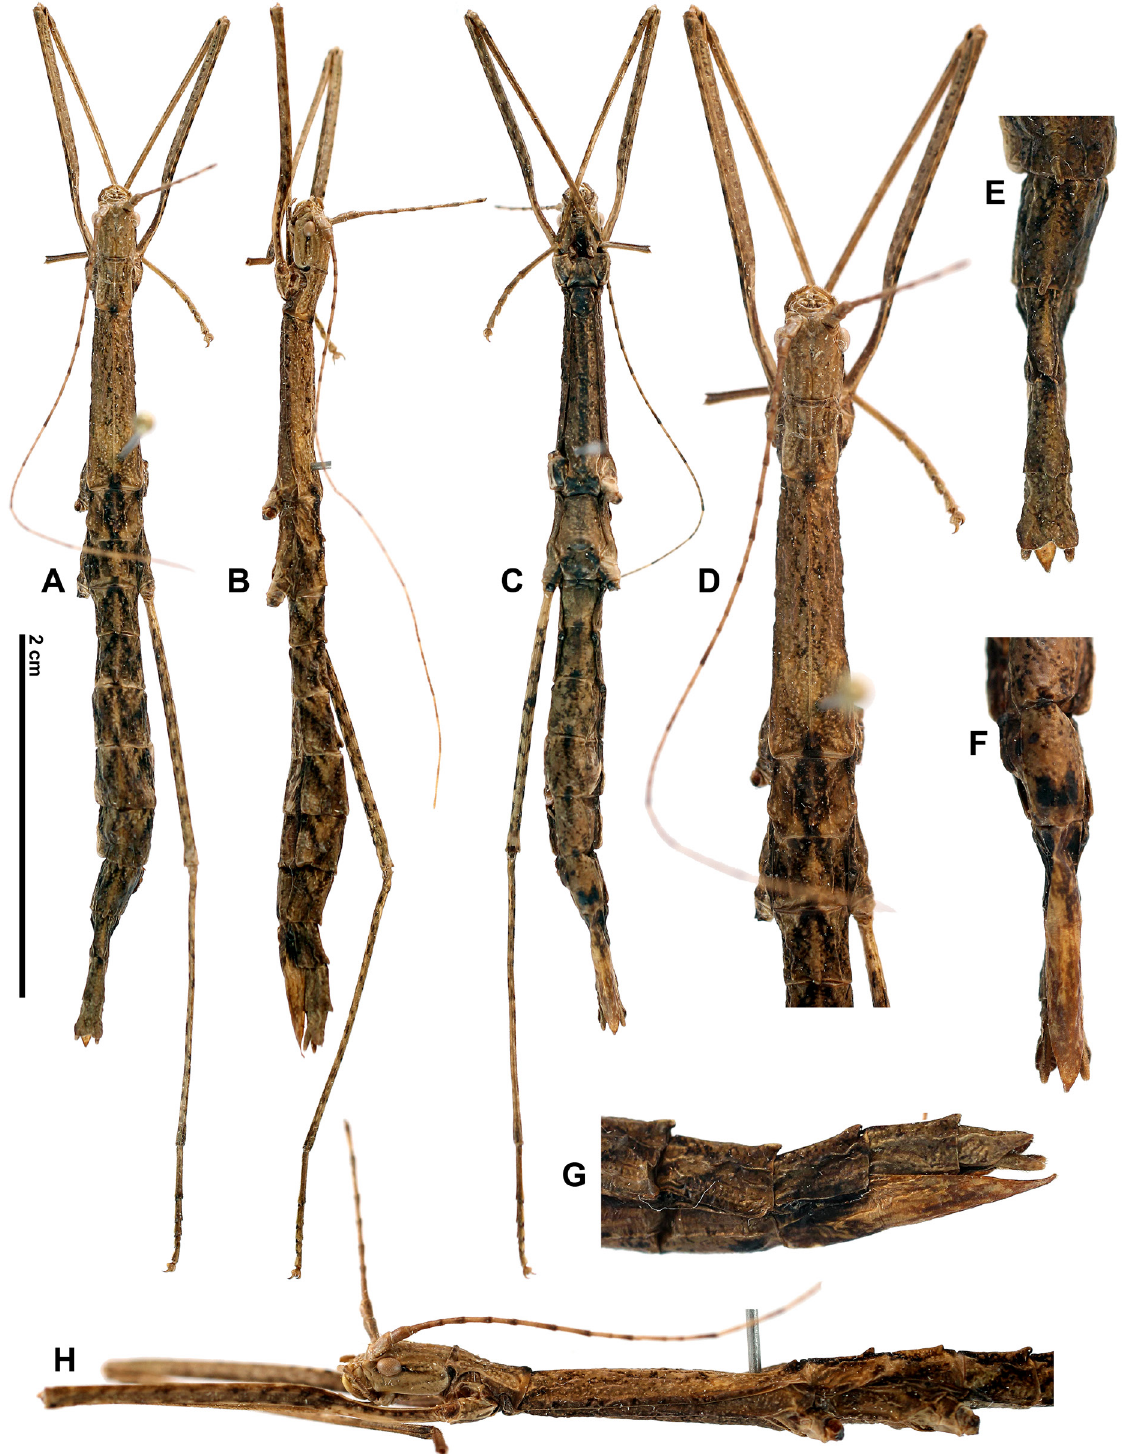
Fig. 16. Capuyanus magwilangi gen. et sp. nov., ♀, paratype. A . Habitus, dorsal view. B . Habitus, lateral view. C . Habitus, ventral view. D . Anterior part of body, dorsal view. E . Apex of abdomen, dorsal view. F . Apex of abdomen, ventral view. G . Apex of abdomen, lateral view. H . Anterior part of body, lateral view. D–H: not to